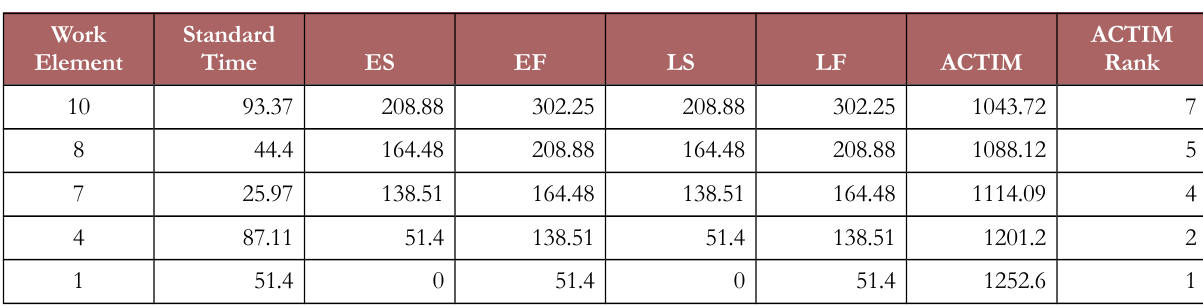
Table 4. Calculation of ES, EF, LS, dan